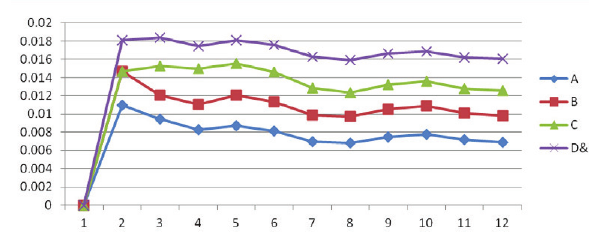
Figure 9b. Accumulated impulse response of PRI to shocks in